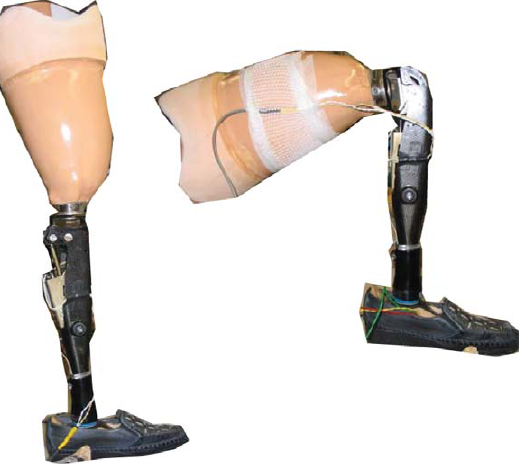
Fig. 2. The constructed prototype of the knee